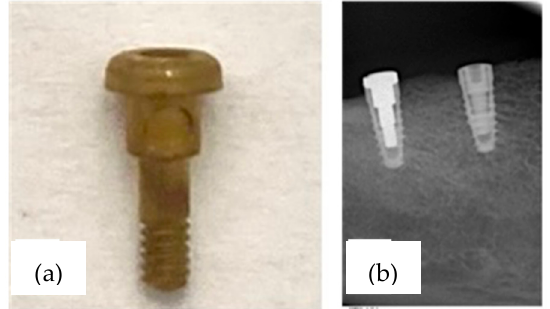
Figure 1. ( a ) Supercharged ® Sc in NeFeB coated in titanium PVD used in the test group; ( b ) Radiographic evaluation of the inserted implants at the end of the surgical procedure.